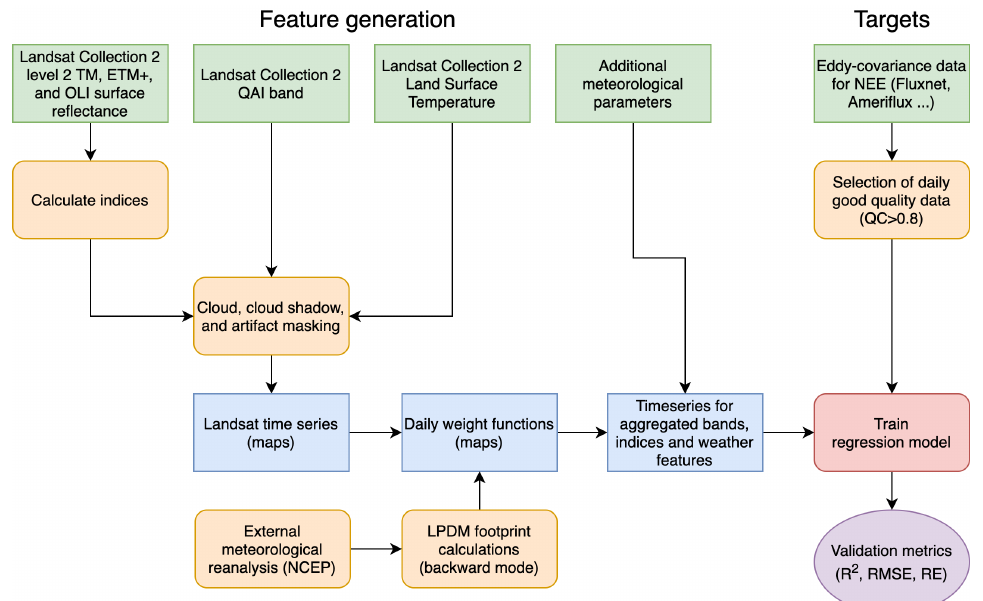
Figure 2. General flowchart of regression model training